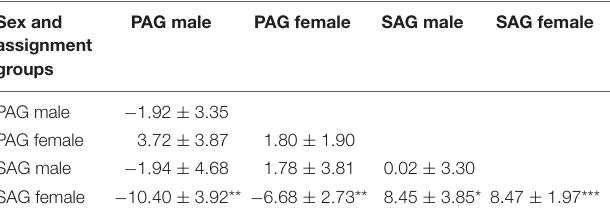
TABLE 3 | Cells along the main diagonal: within-group change over time in RBANS total scale. Off-diagonal terms: group differences in RBANS total scale. Sex and PAG male PAG female SAG male SAG female assignment groups PAG male − 1 . 92 ± 3 .